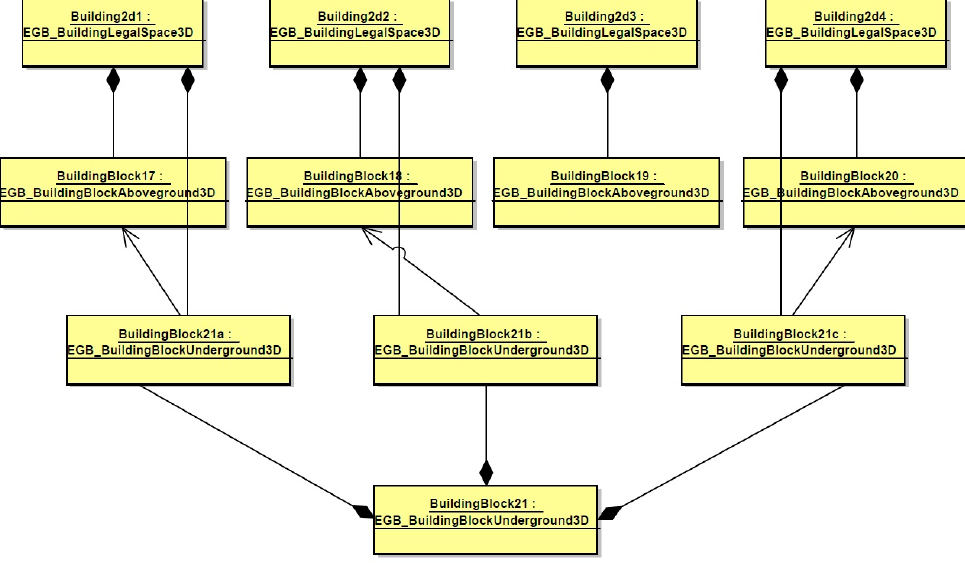
Figure 18. The UML schema of instance where the underground part is divided between properties having access to it (in this case three properties).